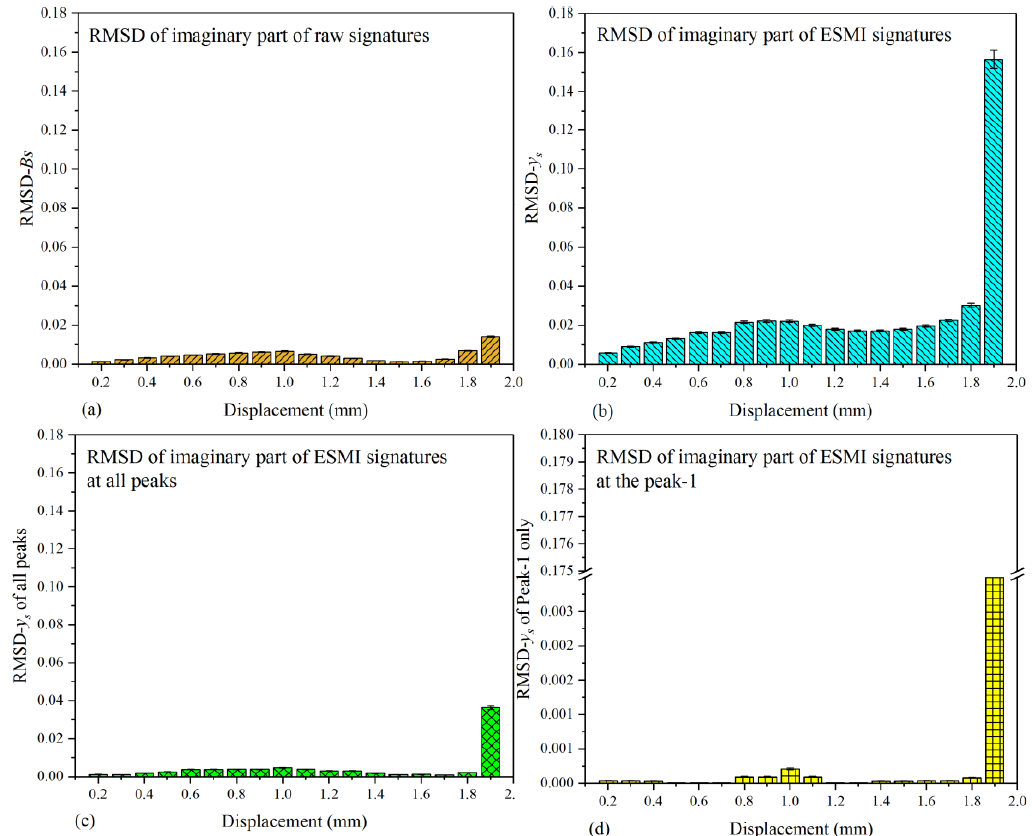
Figure 10. Comparative RMSD histograms based on imaginary part of signatures in all testing states: ( a ) raw G s signatures; ( b ) extracted x s signatures; ( c ) extracted x s signatures at all peaks; ( d ) extracted x s signatures at Peak-1 only.